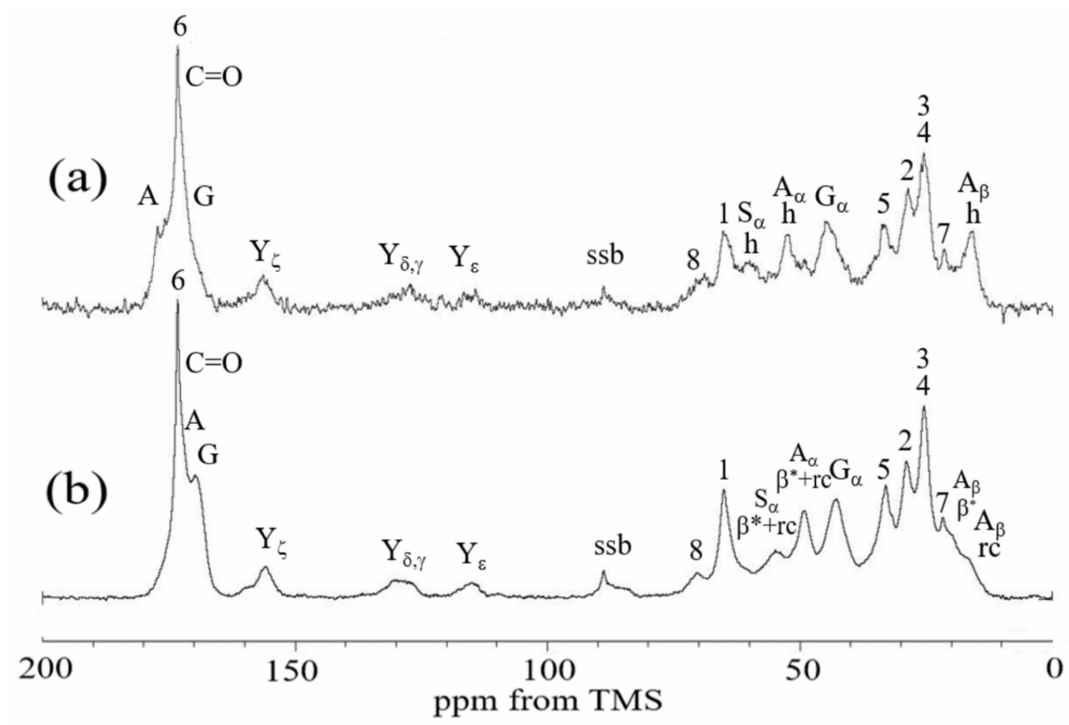
Figure 3. 13 C CP/MAS NMR spectra of ( a ) Sample I and ( b ) Sample II in the dry states. β *: anti-parallel β -sheet, h: 3 10 helix, and rc: random coil. The number of each carbon indicates the PU peaks noted in Figure